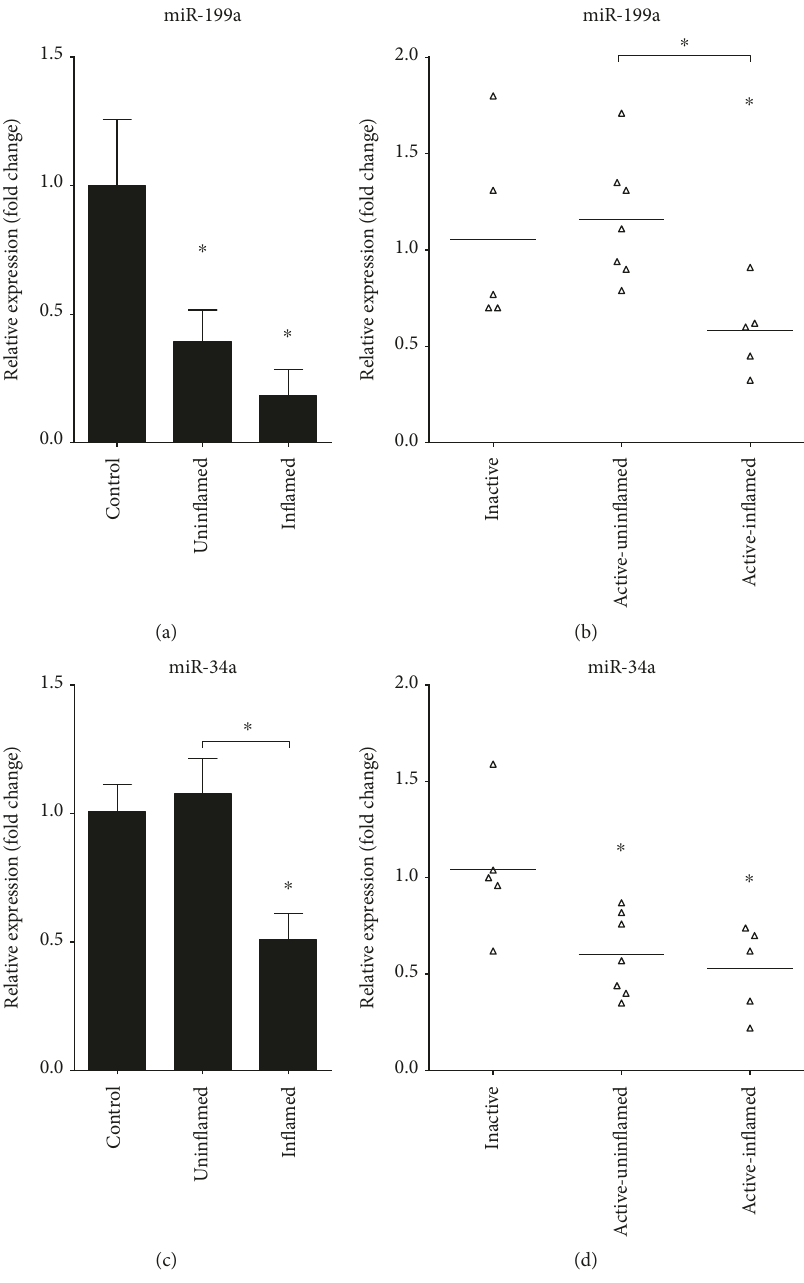
Figure 3: Decreased expression of miRNAs regulating Axl in in fl amed colon. The relative expression of miR-199a (a, b) and miR-34a (c, d) is shown from rat (a, c) and human (b, d) samples. Data on panels (a) and (c) represent control (left columns, n = 2 ), unin fl amed (middle columns, n = 6 ), and in fl amed (right columns, n = 6 ) rat colon sections and are presented as the mean ± SEM; data on panels (b) and (d) represent inactive (left, n = 5 ), active-unin fl amed (middle, n = 7 ), and active-in fl amed (right, n = 5 ) colon samples of IBD patients where dots and lines represent individual values and the mean; ∗ p < 0 05